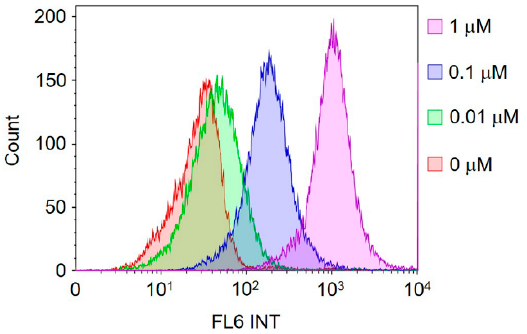
Figure 7. FACS quantification of A549 cells fluorescence intensities after 1 h of incubation with Cy5-BF 3 ( 19 F) at different concentrations.